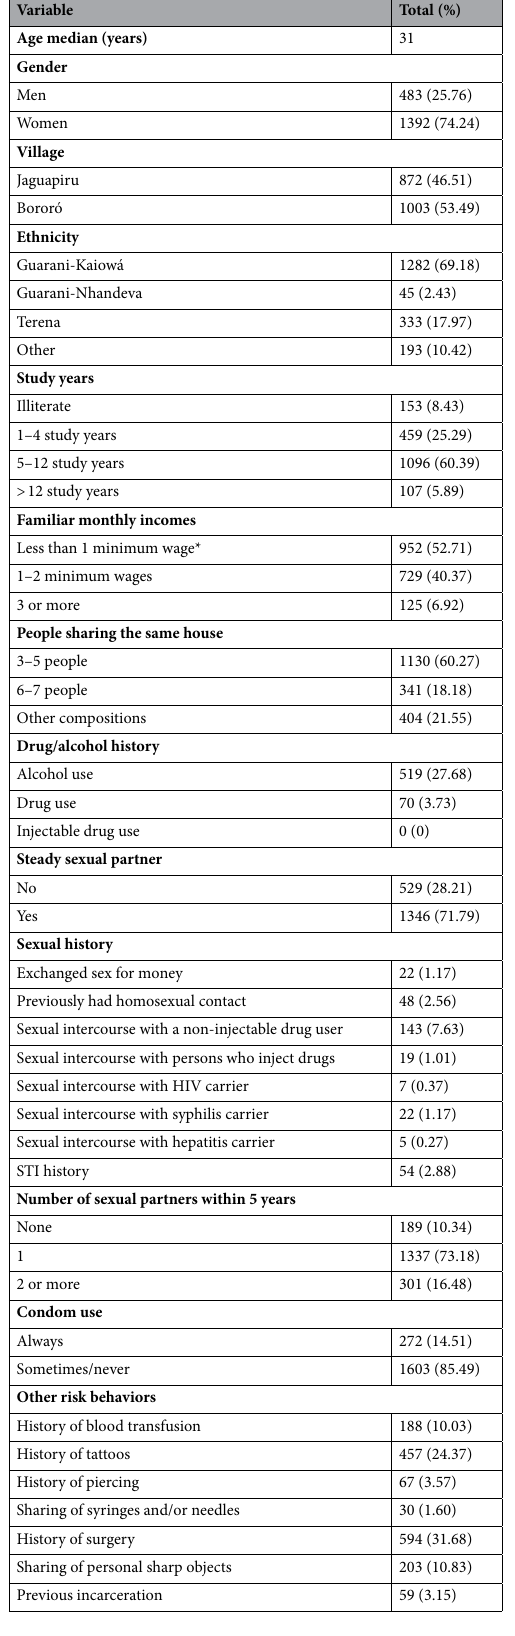
Table 1. Characteristics of 1875 indigenous people of the study. *The national minimum wage at the time converted todollar was 190.00 USD. a The total represents the number of individuals who answered the question . Percentages were calculated excluding missing